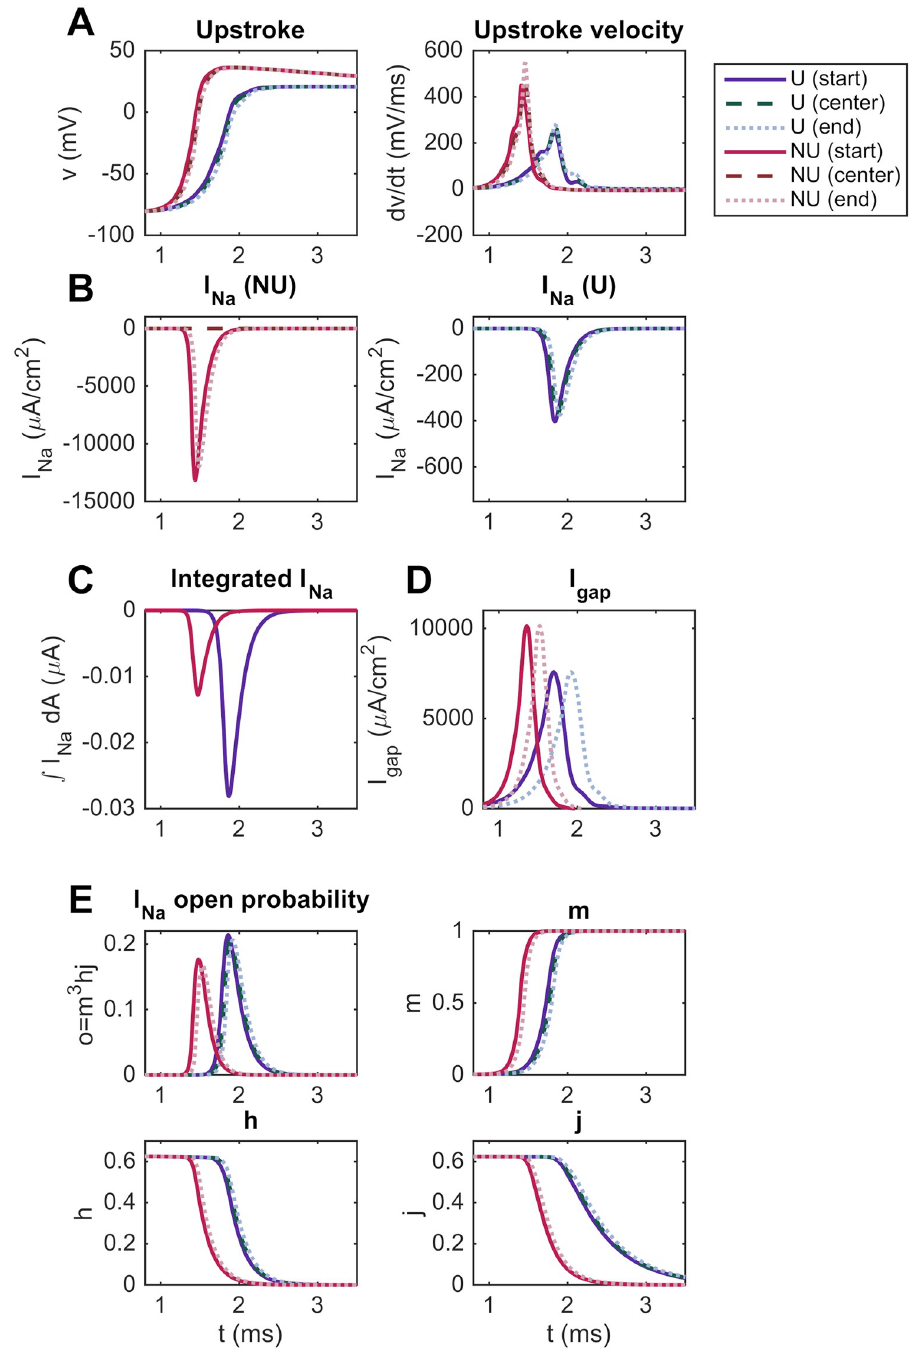
Fig 7. The upstroke velocity and gap junction currents are increased for the NU sodium channel distribution. Comparison of the action potential upstroke and upstroke velocity (A), I Na (B), integrated I Na (C), I gap (D), and gating dynamics of I Na (E) for the U and NU cases (see Fig 3A and 3B). The parameters used in the simulations are given in Table 1, and the simulations include 15 cells. We consider the seventh cell and record the membrane potential, upstroke velocity and currents for the first x -value, the center x -value and the last x -value of the cell.